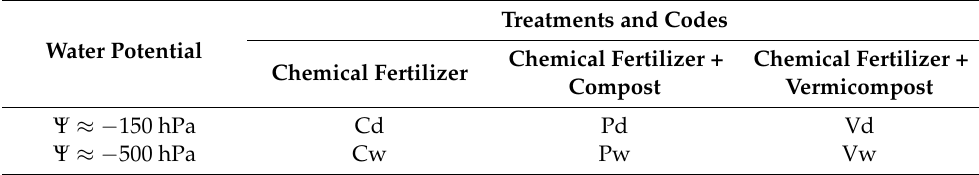
Table 3. The experimental treatments and their codes.